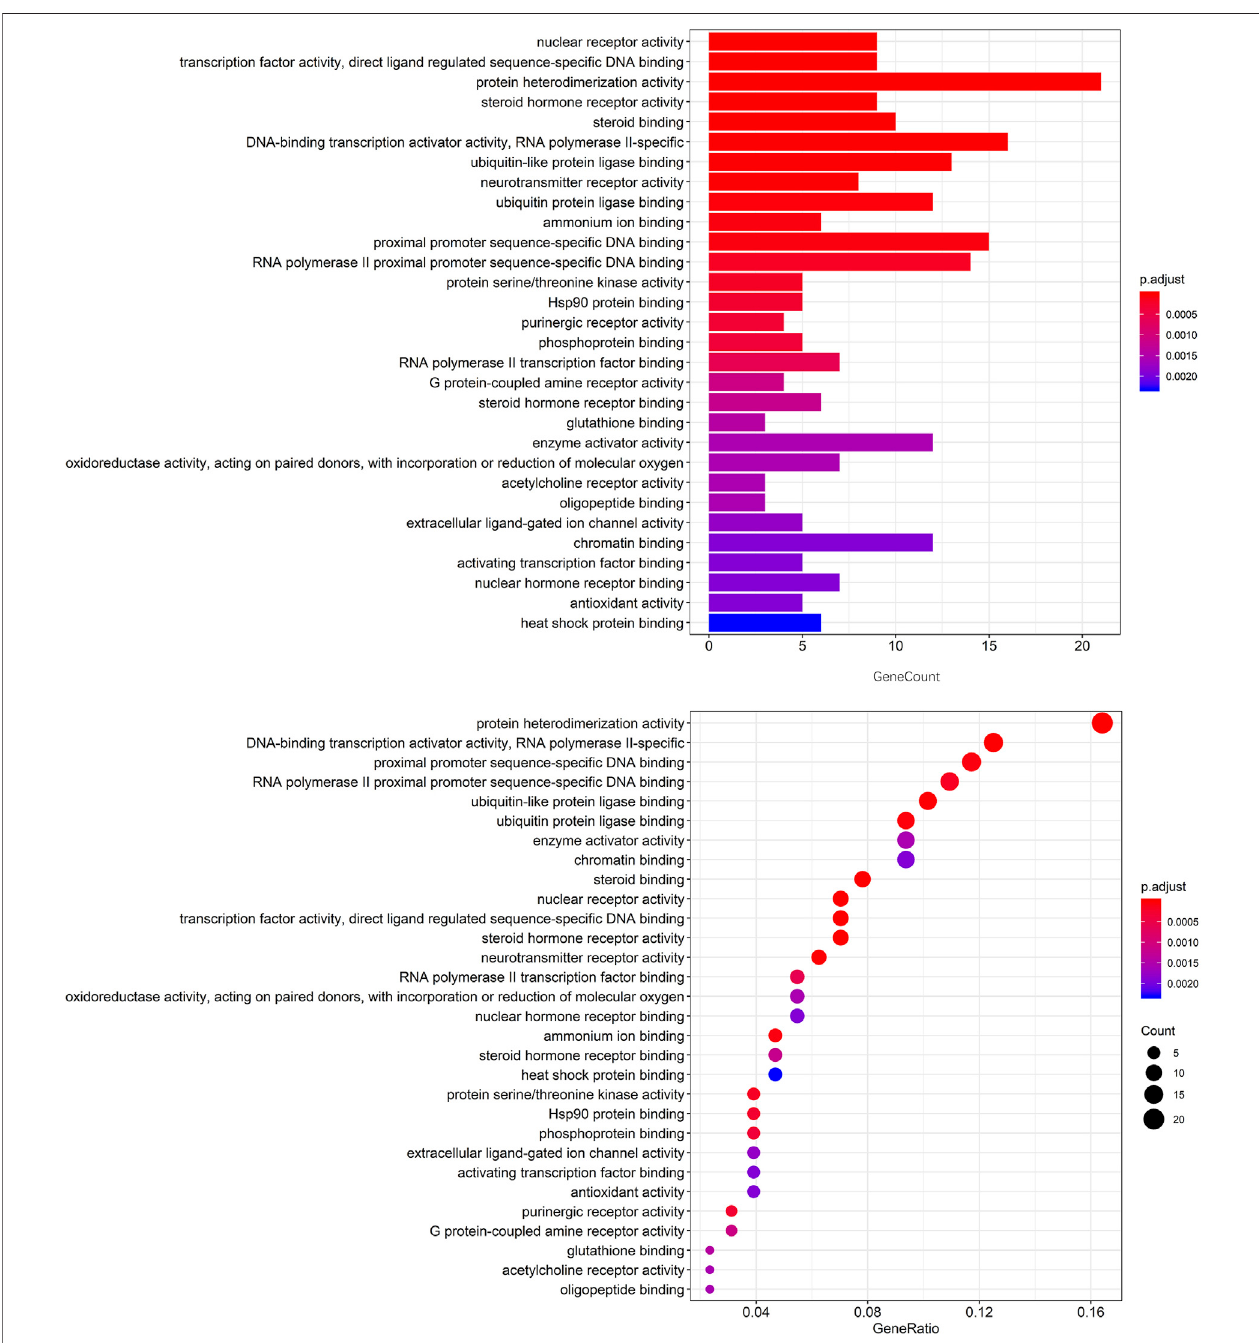
FIGURE 3 | The top 30 of GO enrichment